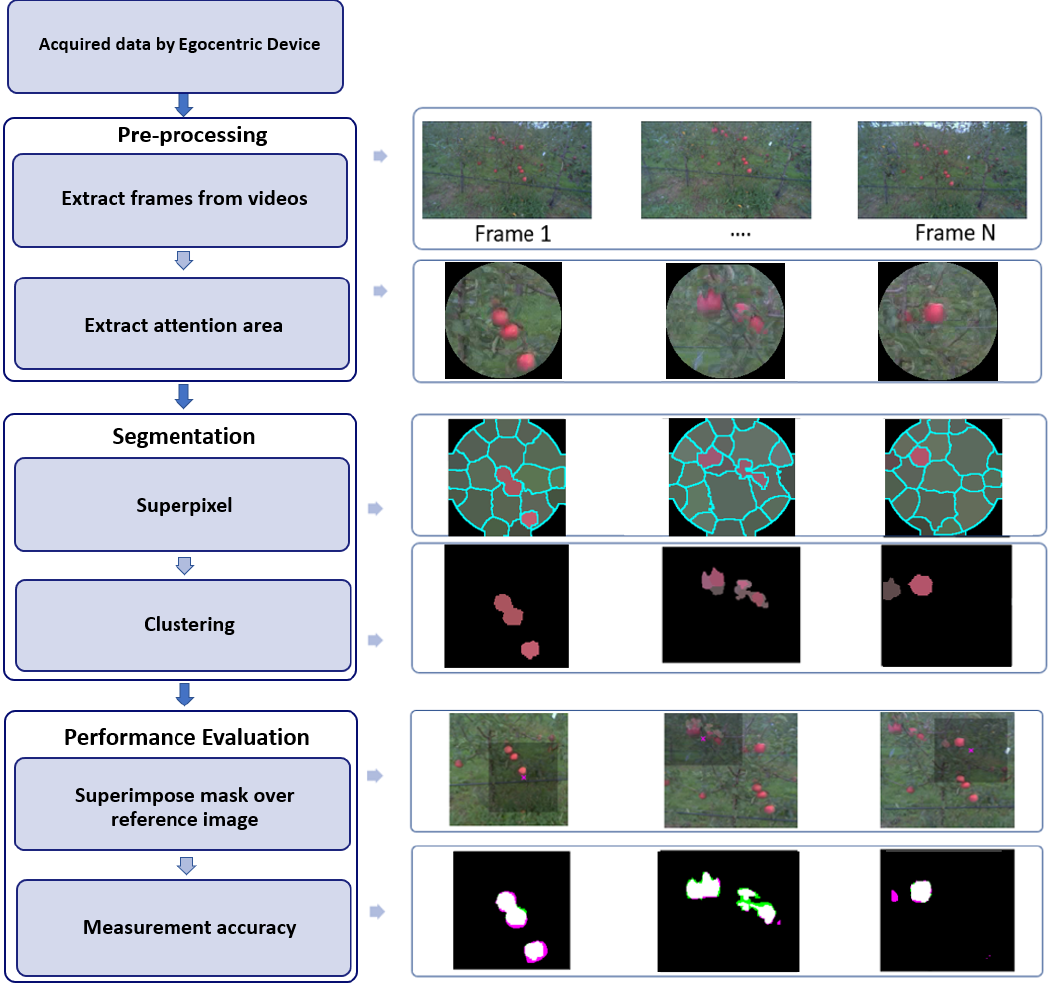
Figure 3. The three-step image processing pipeline proposed to automatically segment apples from the attention areas captured with egocentric